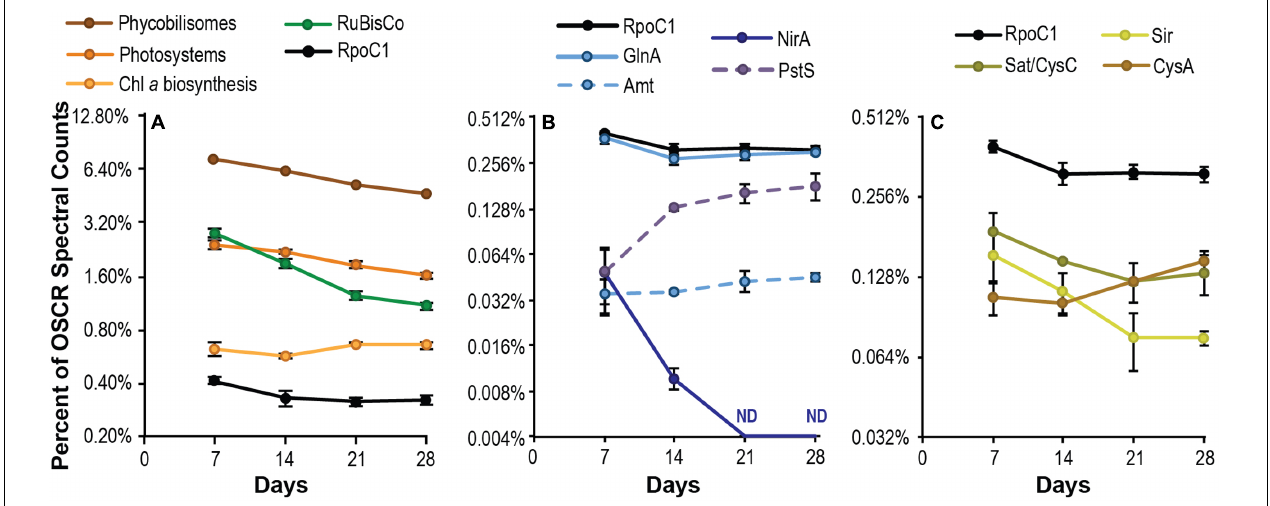
FIGURE 3 | Cyanobacterial energy capture and macronutrient acquisition during succession. Expression of Phormidium sp. OSCR proteins involved in light energy capture and carbon fixation (A) , nitrogen and phosphorus acquisition (B) and sulfur acquisition (C) , expressed as a percentage of total spectral counts per sample attributed to this species. The expression of the large subunit of the cyanobacterial beta’ subunit of RNA polymerase, RpoC1, is provided for reference in all panels. Data are plotted on a log 2 scale; error bars represent the 95% confidence interval of the mean. For energy and carbon capture systems (A) , data represent a sum of all the subsystem-specific cyanobacterial gene products notated in Supplementary Table S2